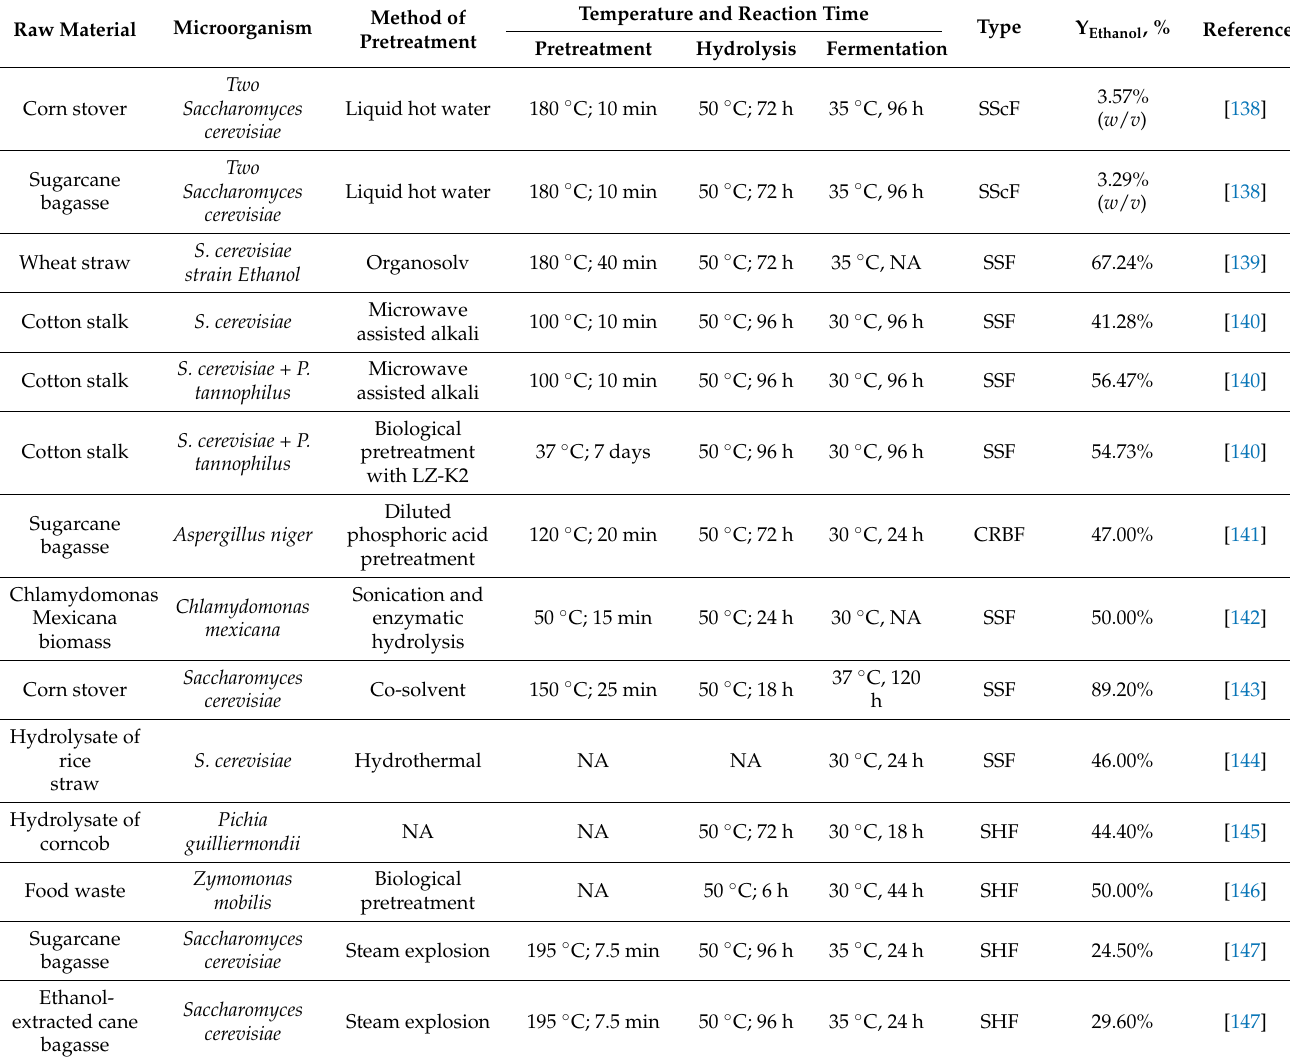
Table 6. Ethanol production using various types of fermentation and